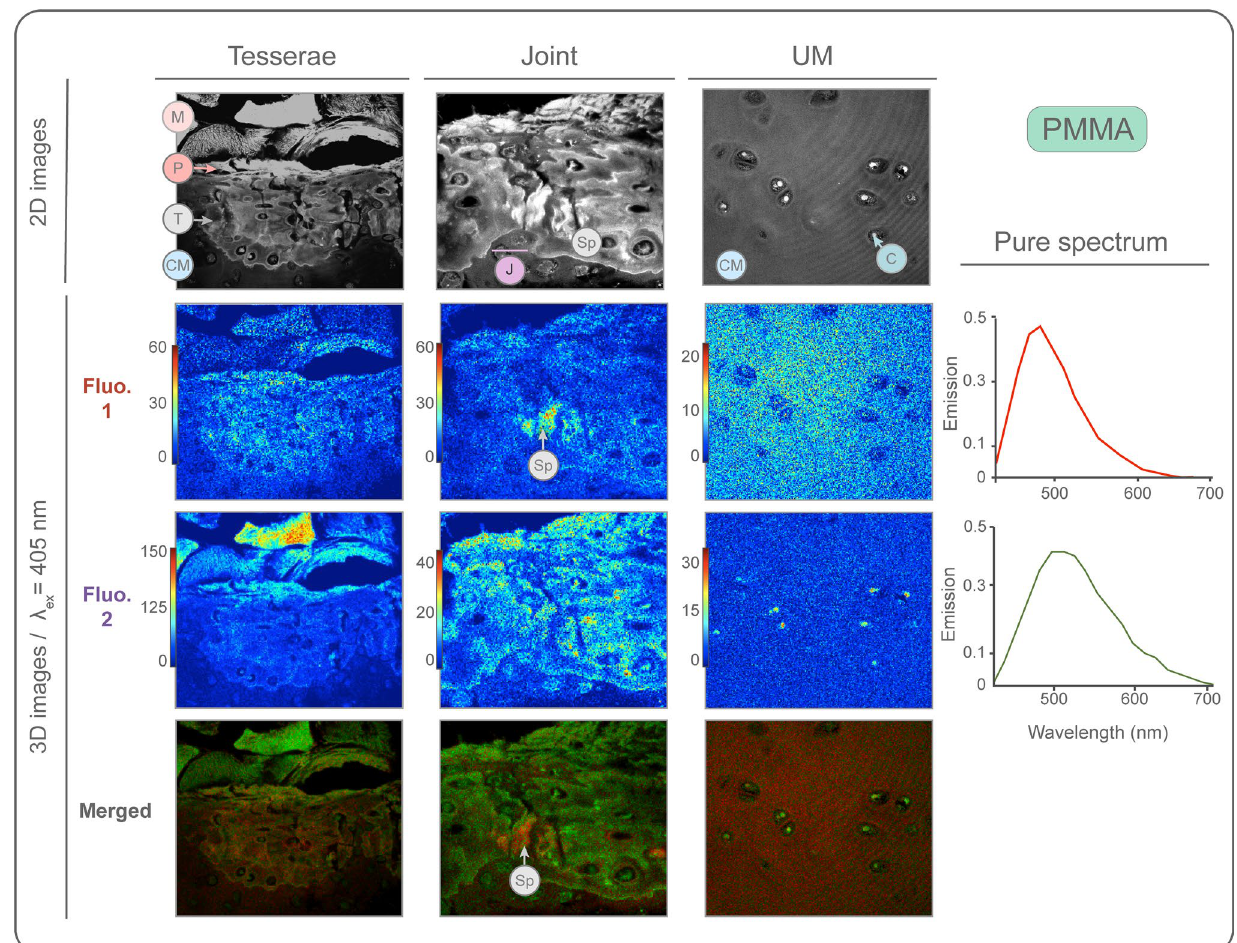
Fig. 10 Distribution maps and pure spectrum of fluorescence signatures detected by MCR-ALS in PMMA samples excited with 405 nm laser. The 2D (grayscale) images (top row) acquired with a 405 nm excitation laser and a wide wavelength emission filter provide reference for overall tissue appearance. The 3D images below show all fluorescence signatures detected with MCR-ALS (Fluo. 1–2), with their correspond- ing spectral signature at the right. Color bars in each image indicate intensity. Merged distribution maps at the bottom overlap both fluores- cence signatures in the same image. Chondrocytes (C), Unmineralized cartilage matrix (CM), Joints (J), Perichondrium (P), Tesserae